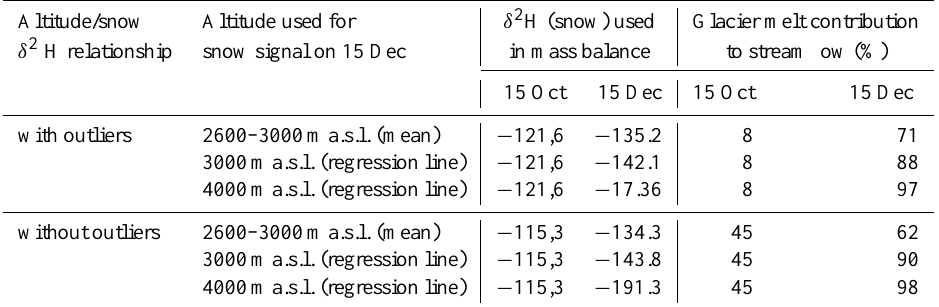
Table 3. Contribution of glacier melt to streamflow on 15 October and 15 December 2011 according to different interpretations of snow isotope data. The first column shows which line from Fig. 6a has been used for the δ 2 H (snow)/altitude relationship and the second column shows which altitude was chosen for snow in the 15 December mass balance calculation. Thereafter, the input snow δ 2 H values for each scenario and the resulting glacier melt contributions are shown.